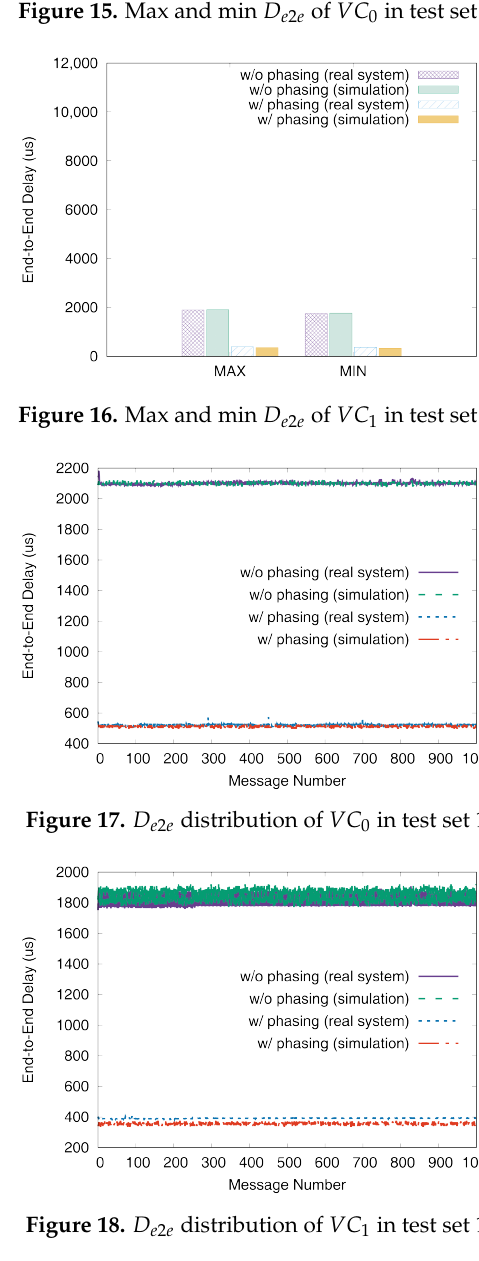
Figure 15. Max and min D e 2 e of VC 0 in test set 1.